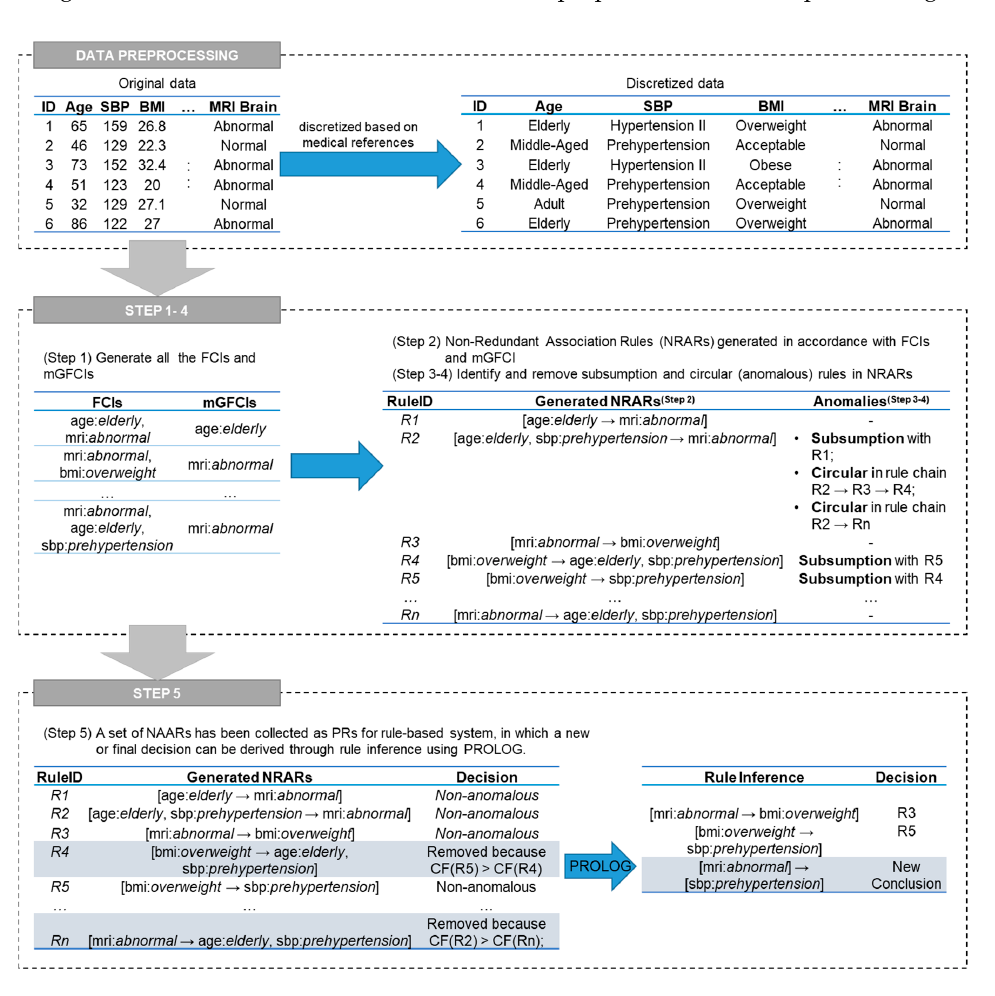
Figure 2. Illustration of the proposed method for rule-based systems on a cerebrovascular examination